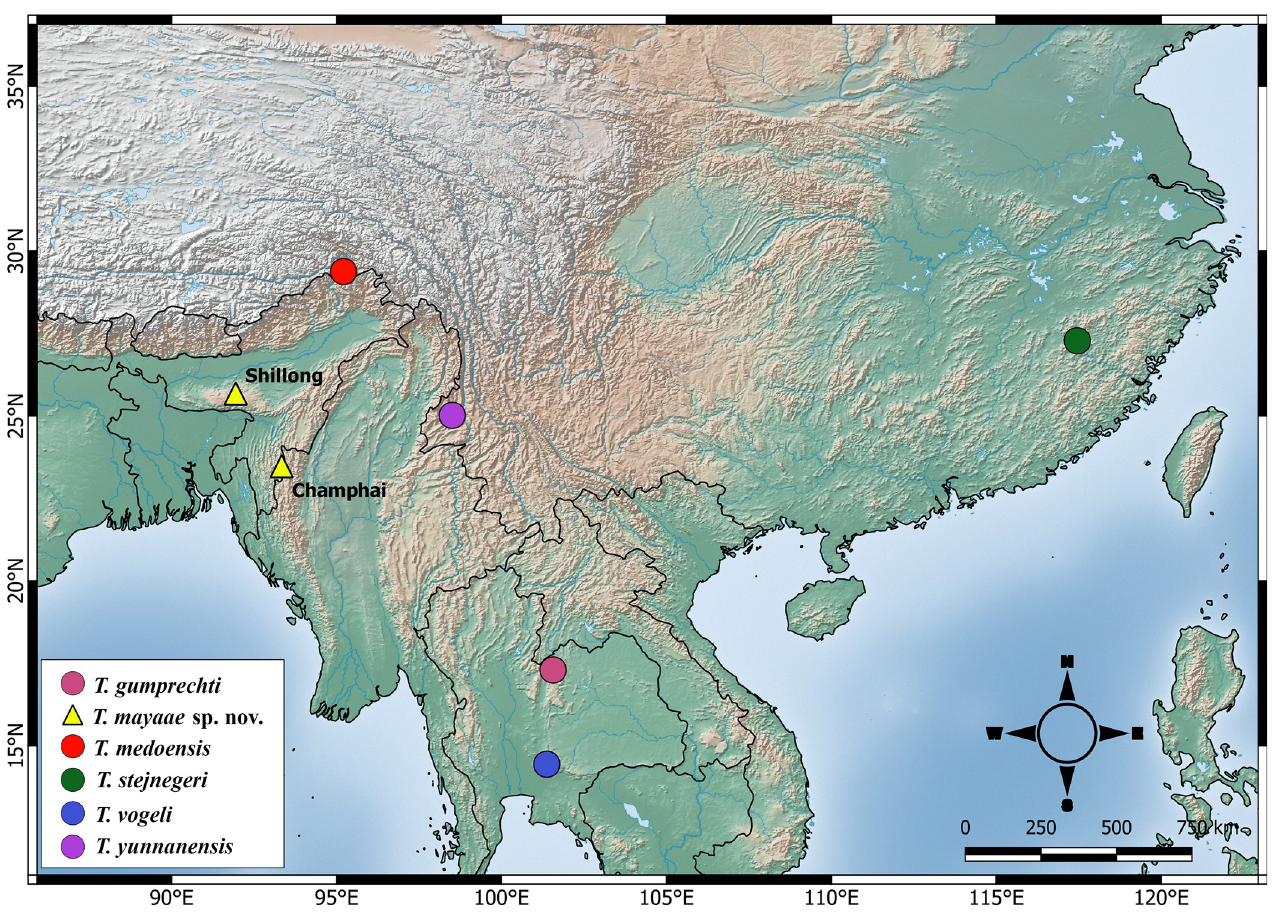
Fig 7. Map showing distribution of the new species and type localities of members of the subgenus Viridovipera .